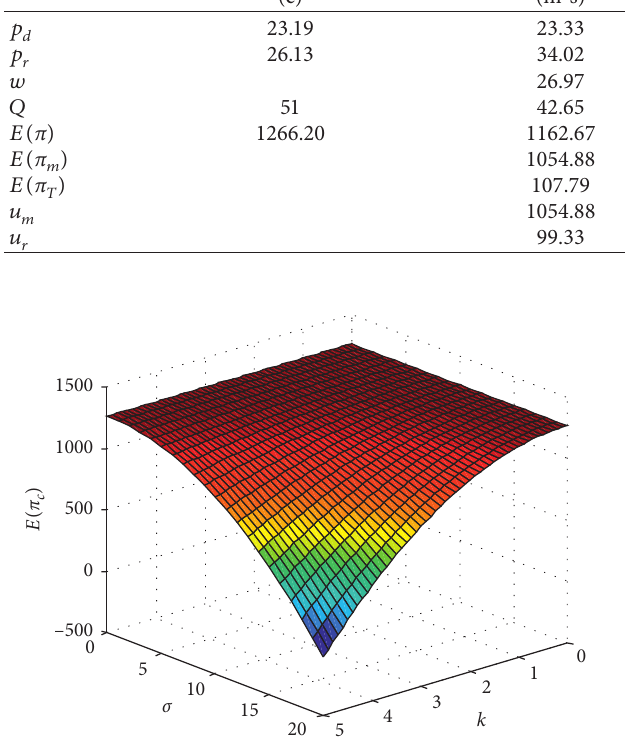
Figure 2: The trend of total profit in the supply chain under the centralized structure.